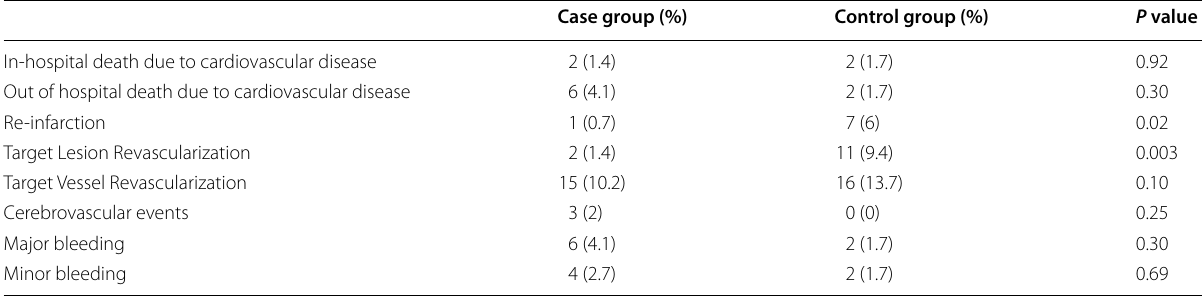
Table 3 Secondary outcomes after primary percutaneous coronary intervention in case and control groups Case group (%) Control group